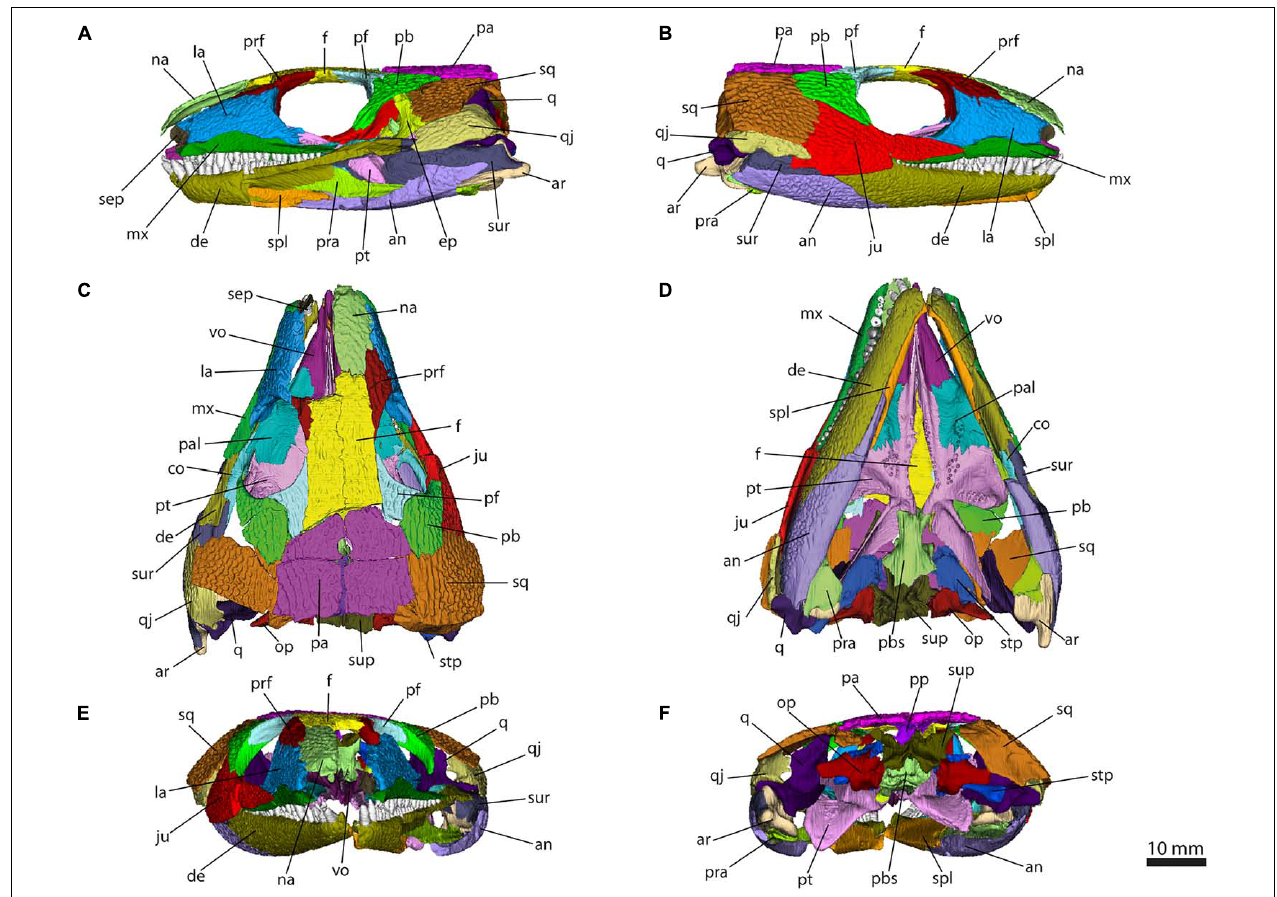
FIGURE 1 | 3D model generated from the scan of OMNH 44816 in left lateral (A) , right lateral (B) , dorsal (C) , ventral (D) , anterior (E) , and posterior view (F) . Abbreviations: an, angular; ar, articular; co, coronoid; de, dentary; ep, epipterygoid; f, frontal; ju, jugal; la, lacrimal; mx, maxilla; na, nasal; op, opisthotic; pa, parietal; pal, palatine; pb, postorbital; pf, postfrontal; pp, postparietal; pra, prearticular; prf, prefrontal; pbs, parabasisphenoid; pt, pterygoid; q, quadrate; qj, quadratojugal; sep, septomaxilla; spl, splenial; sq, squamosal; stp, stapes; sup, supraoccipital; sur, surangular; vo,